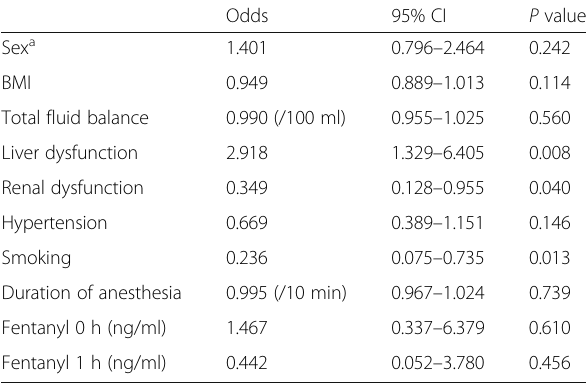
Table 2 Results of multivariable logistic regression analyses for development of